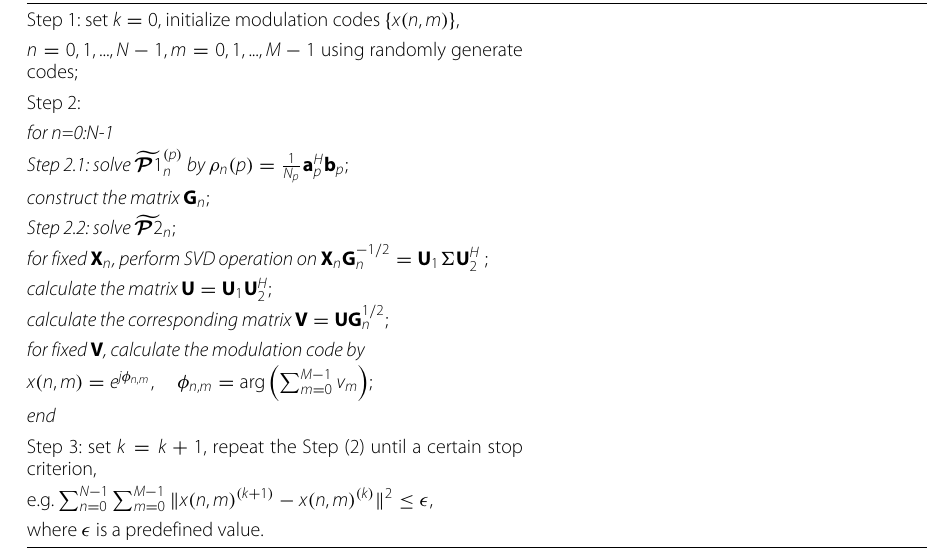
Table 1 The SVD-USSD